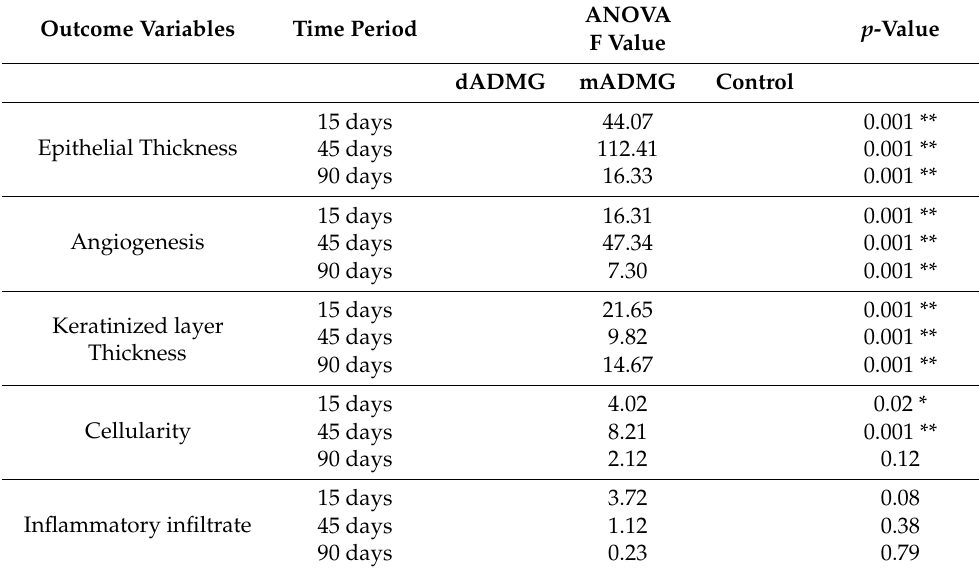
Table 3. one-way ANOVA for the comparison of changes in outcome parameters between ADMG grafts and control groups at various